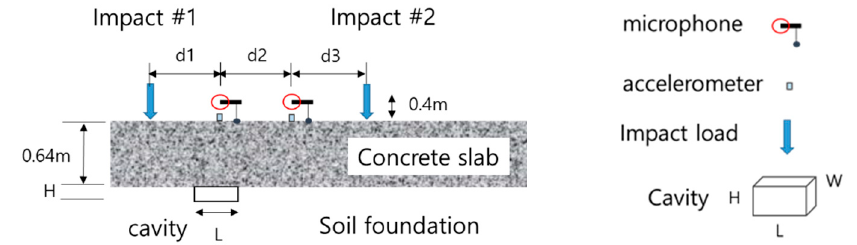
Figure 13. Detailed description of sensor location with impact loading. Table 4. Detailed definitions of gap sizes and sensing positions.